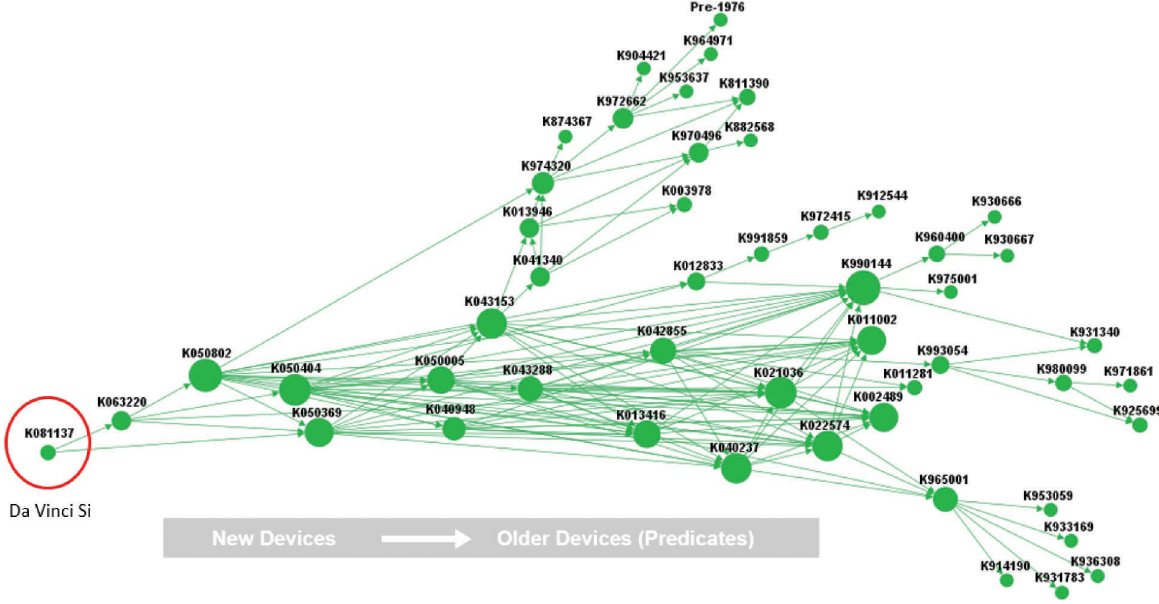
Fig 1. Expanded Da Vinci Si predicate trace. A breakdown of the devices present in the trace color-coded by product code is pictured in Fig 2 below. The most prevalent code is NAY for computer controlled surgical systems. The